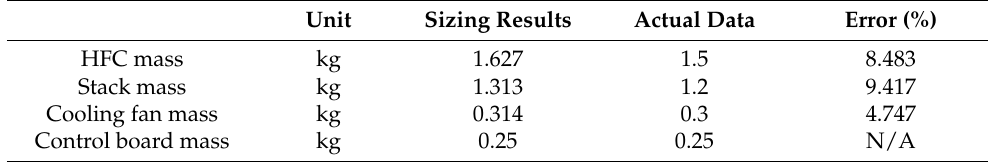
Table 11. Comparison of HFC sizing results and actual data that was developed by Nexcoms [38].